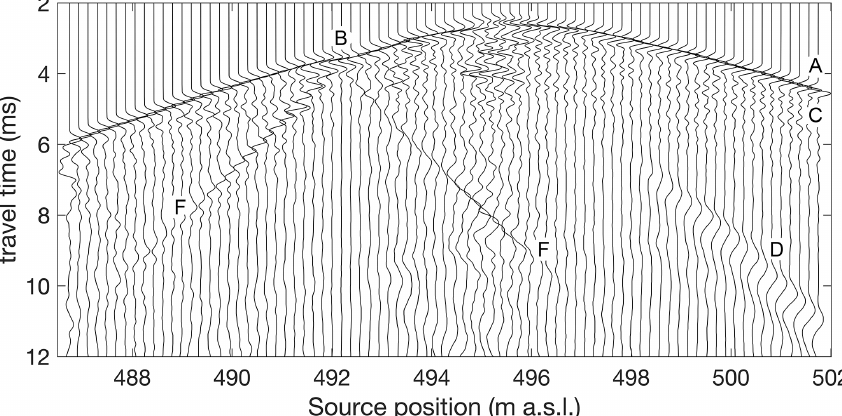
Figure 13. Common receiver gather of processed seismic data recorded with a cemented geophone in borehole BCS-D3 while a P-wave sparker source was employed at 25cm intervals in borehole BCS-D4. Labeled seismic events are the P-wave arrivals (A) with a notable delay for sources fired within the main fault (B), slow and fast S-wave modes (C), a tube wave propagating along the source borehole (D), and a tube wave reflected at the main fault